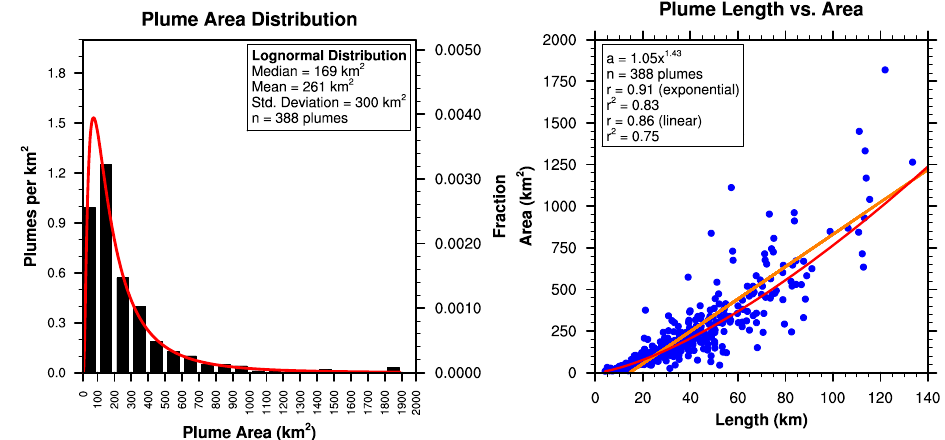
Fig. 4. Histogram of (a) plume area with best-fit lognormal distribution overlaid (red curve), and (b) exponential Eq. (9) and linear Eq. (10) relationship between length and area. Panel (a) omits 1 plume (area = 2716km 2 ) included in the analysis, and panel (b) omits 3 plumes (lengths 149, 188, and 225km) included in the